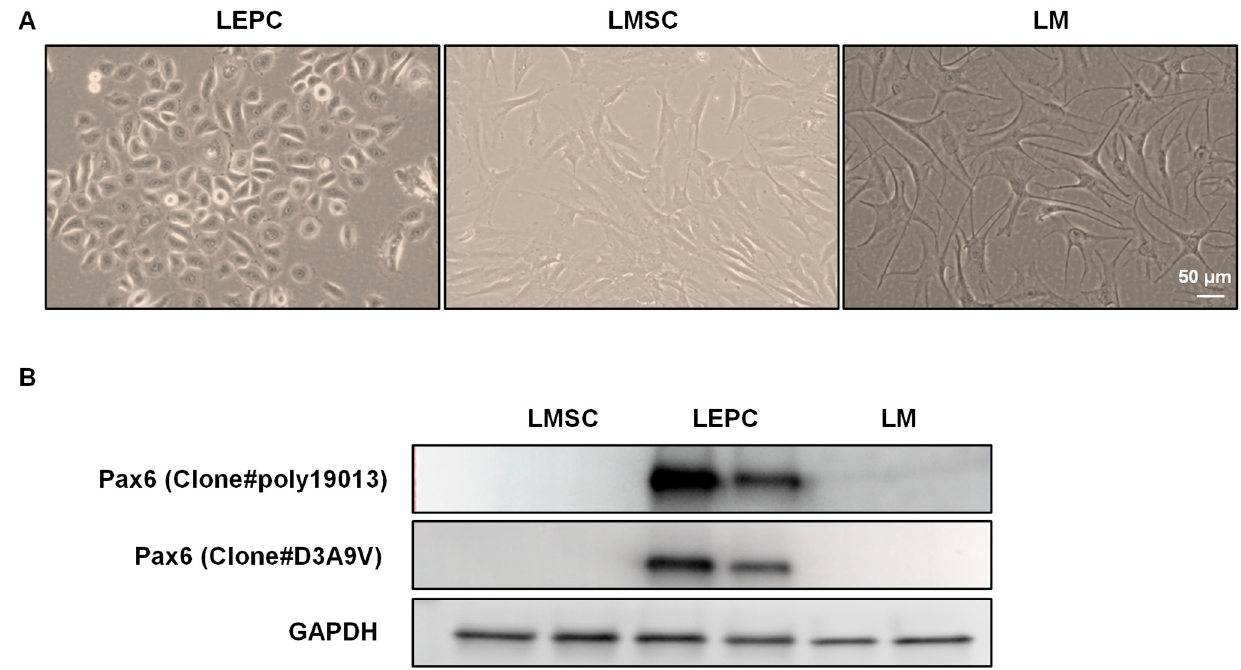
Figure 4. PAX6 expression on cultured limbal cells. ( A ) Phase contrast images showing the small cuboidal epithelial phenotype of limbal epithelial progenitor cells (LEPC, P1), spindle ‐ shaped morphology elongated with prominent nucleolus of mesenchymal stromal cells (LMSC, P1), and large, flattened, smooth bodies with multiple dendrites of melanocytes (LM, P1). ( B ) Western blot analysis showing the PAX6 (both clones) expression in LEPC but not in LMSC or LM. Reprobing with an anti ‐ GAPDH antibody served as a control. Uncropped versions of the Western blot are shown in Supplementary Figure S2.